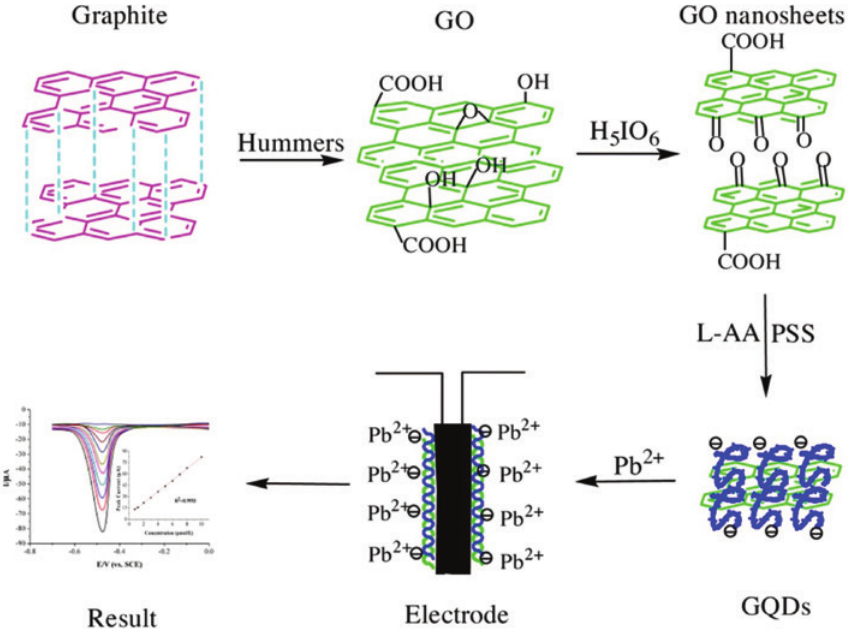
Figure 2: Schematic diagram of the synthesis of GQDs for electrochemical detection (reprinted/reproduced with the permission of Ref. [67], copyright 2014, Elsevier